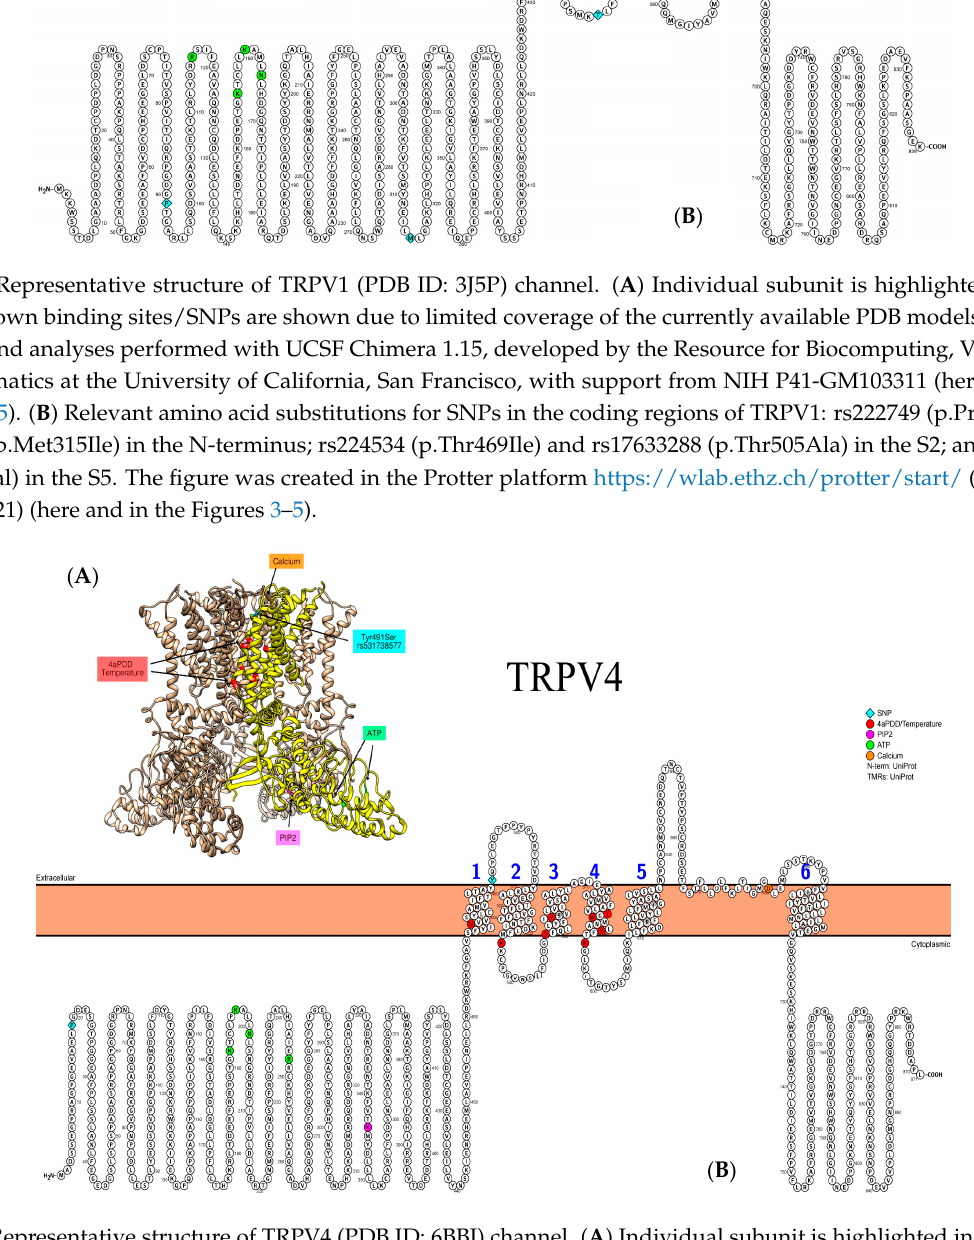
Figure 3. Representative structure of TRPV4 (PDB ID: 6BBJ) channel. ( A ) Individual subunit is highlighted in yellow. Not all known binding sites/SNPs are shown due to limited coverage of the currently available PDB models. ( B ) Relevant amino acid substitutions for SNPs in the coding regions of TRPV4: rs3742030 (p.Pro19Ser) and rs531738577